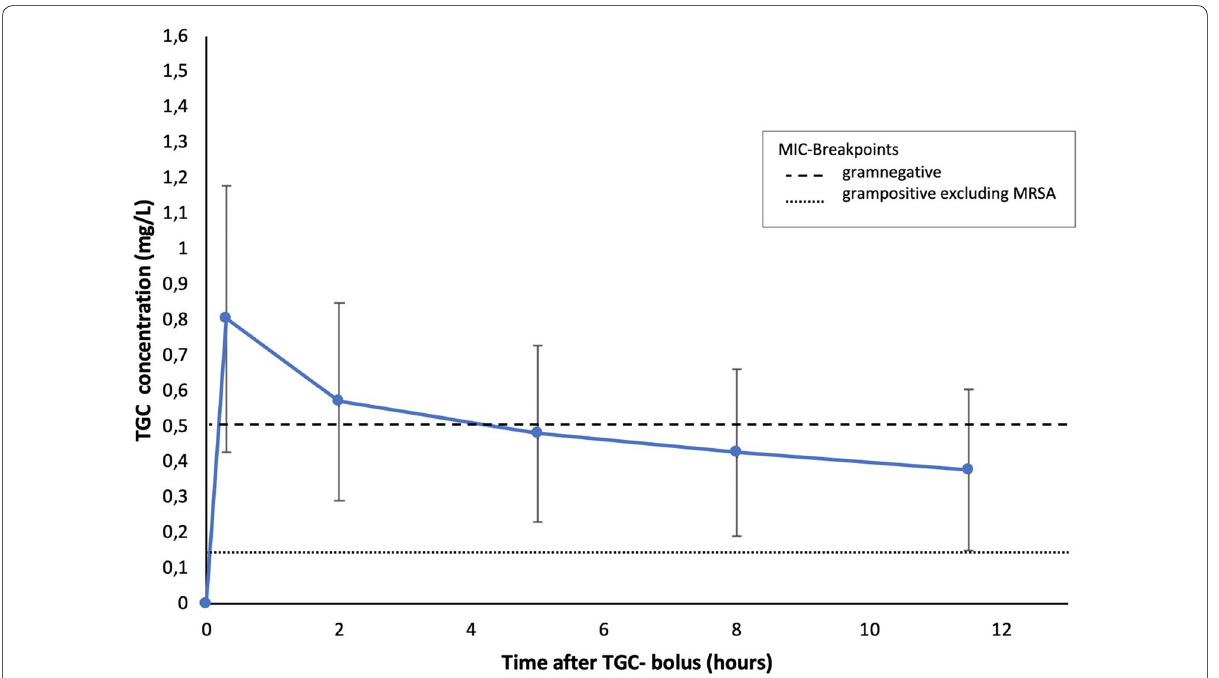
Fig. 1 Mean TGC plasma concentrations depending in the study population. Data are presented as mean